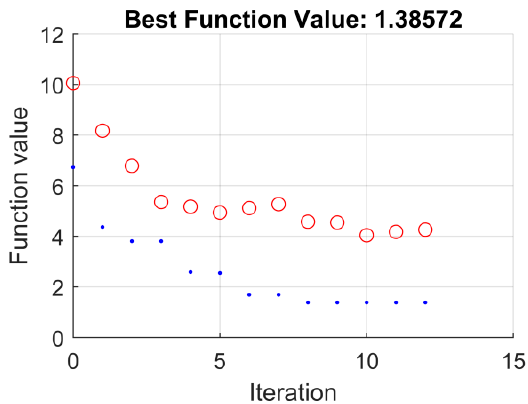
Figure 25. Adaptation process for the controller with type II functions.